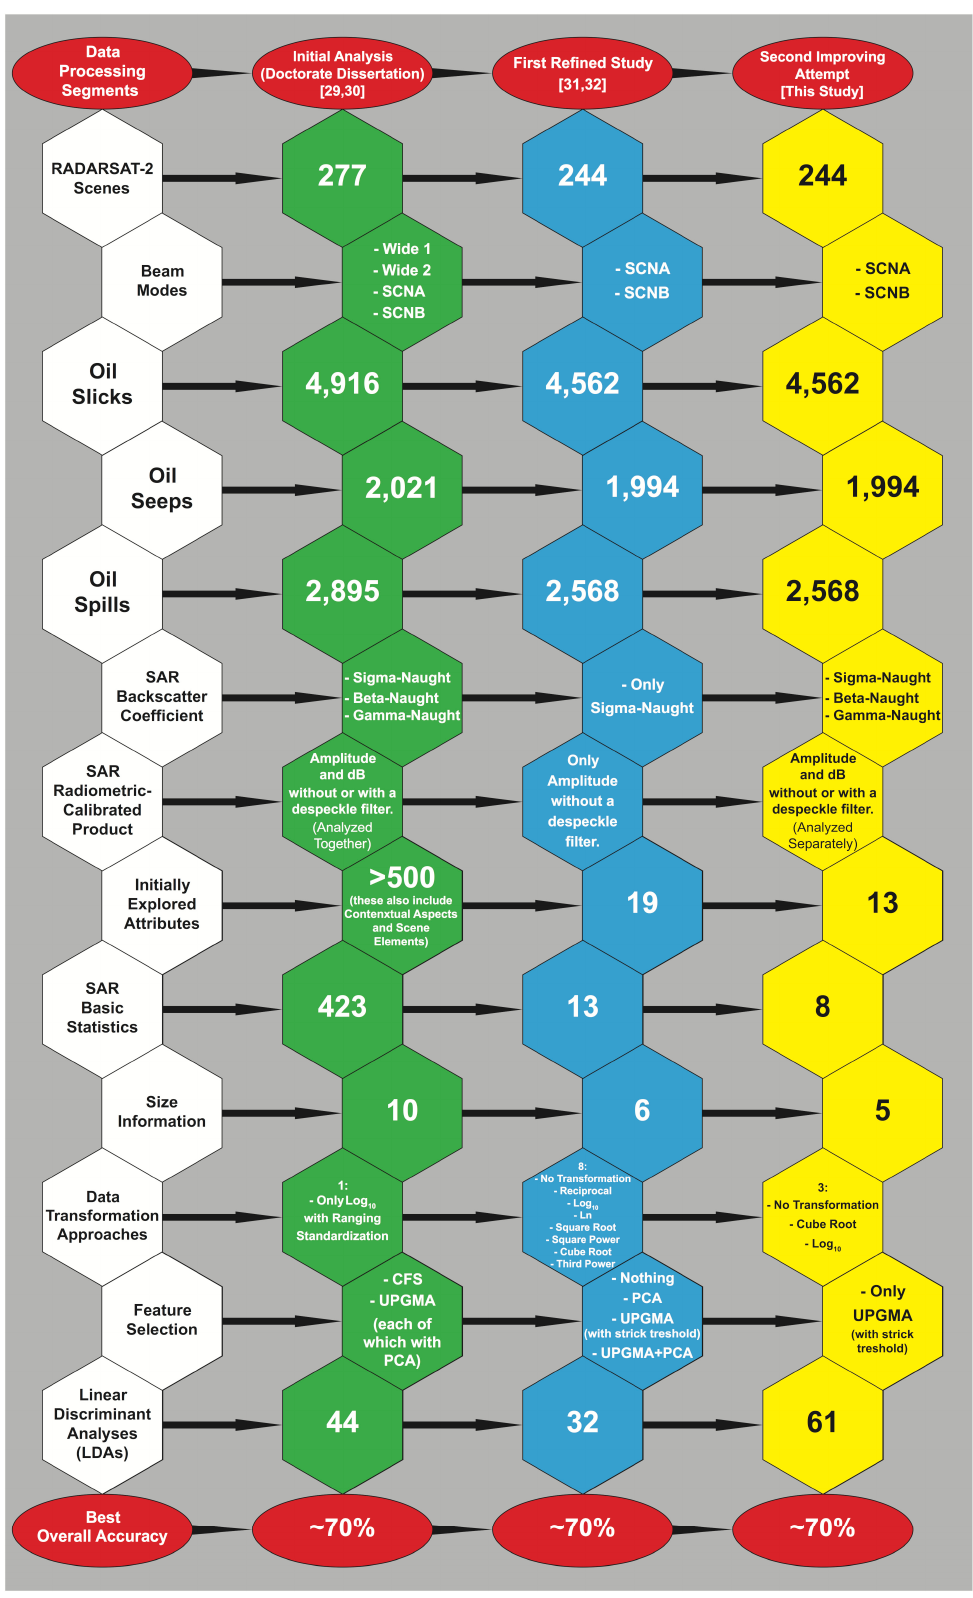
Figure 3. Sequential portrayal of our exploratory data analysis compared to those of our earlier investigations [29–32]. See the text for more details.